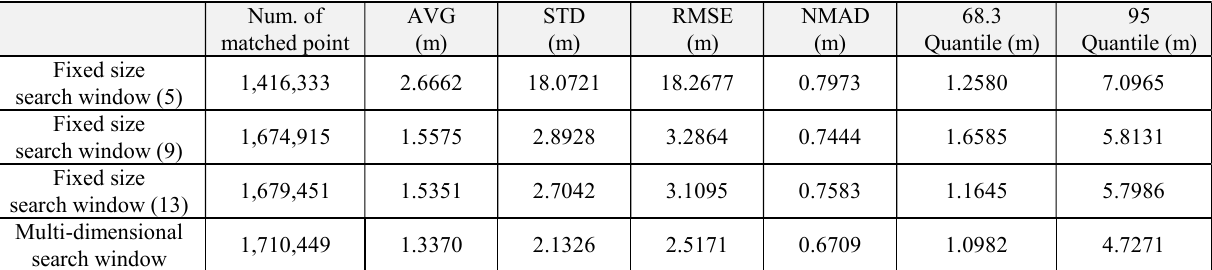
Table 1. The performance comparison between fixed patch size and multiple image patch Num. of